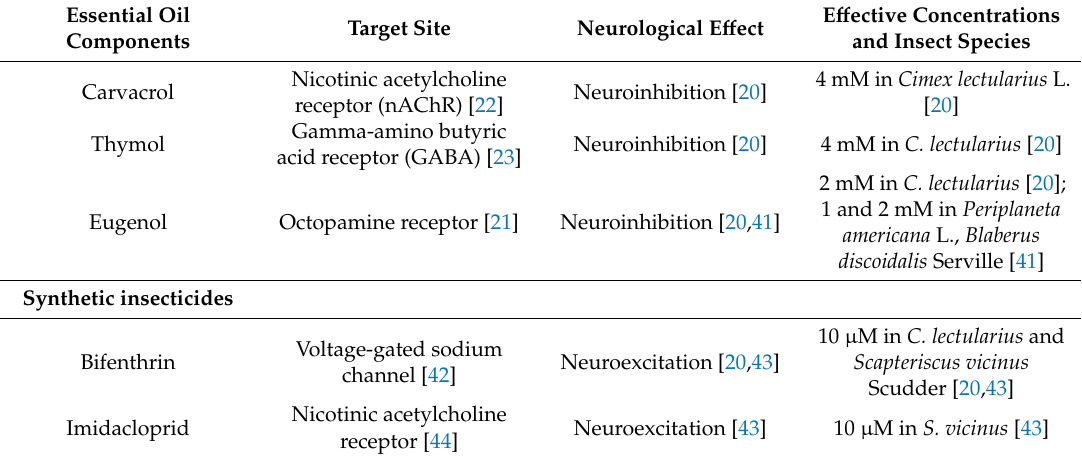
Table 2. Information regarding the target sites and neurological e ff ects caused by plant essential oil components and synthetic insecticides used in the current